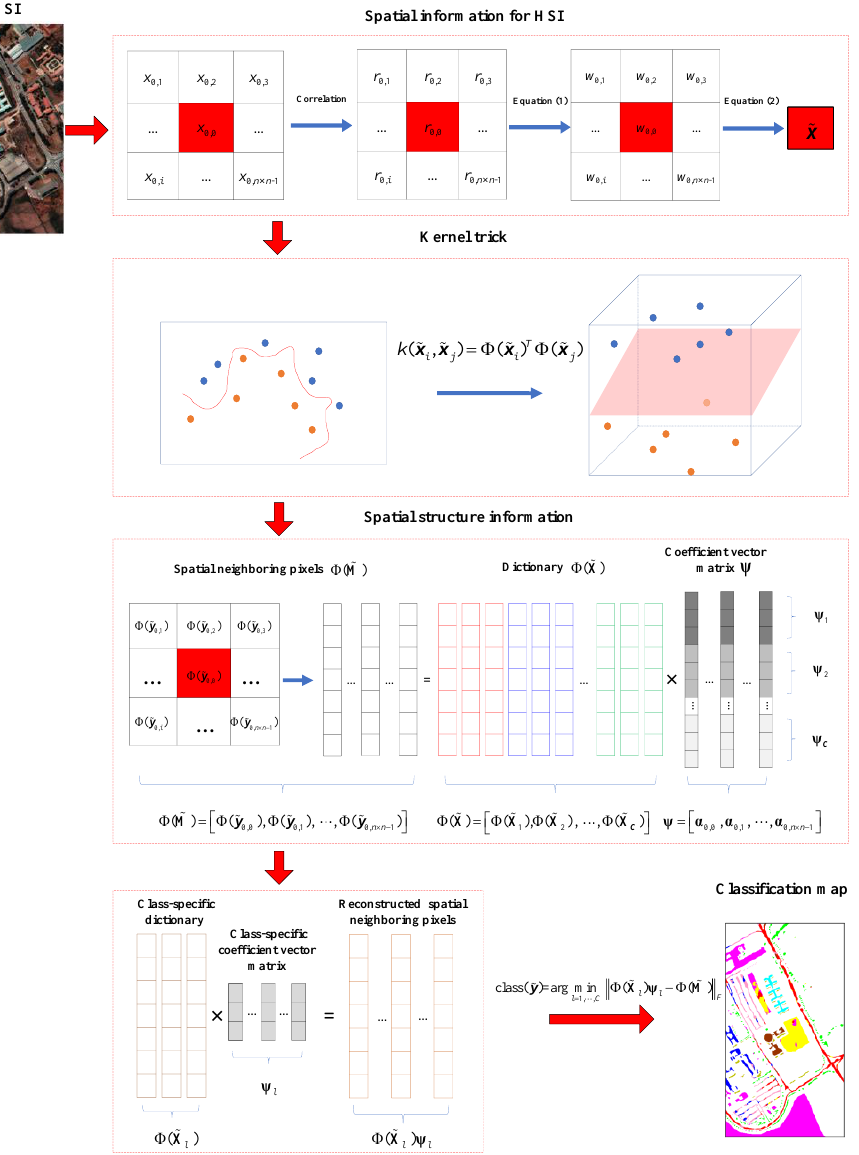
Figure 4. The flowchart for the proposed WSSJKCRC